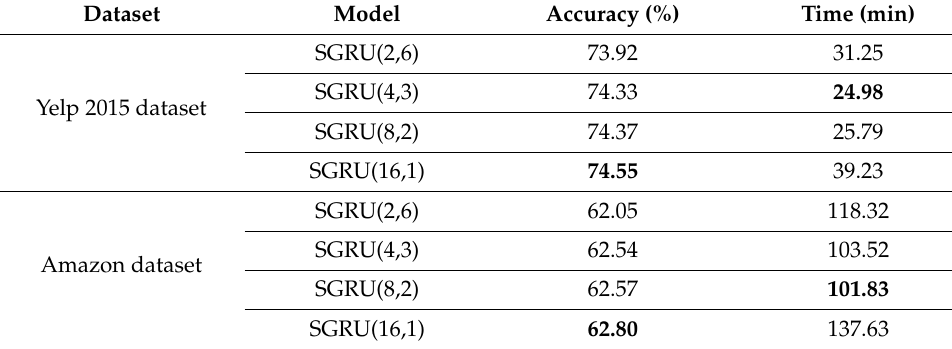
Table 5. The accuracy and training time of the models on each dataset. Results that surpass all competing methods are bold